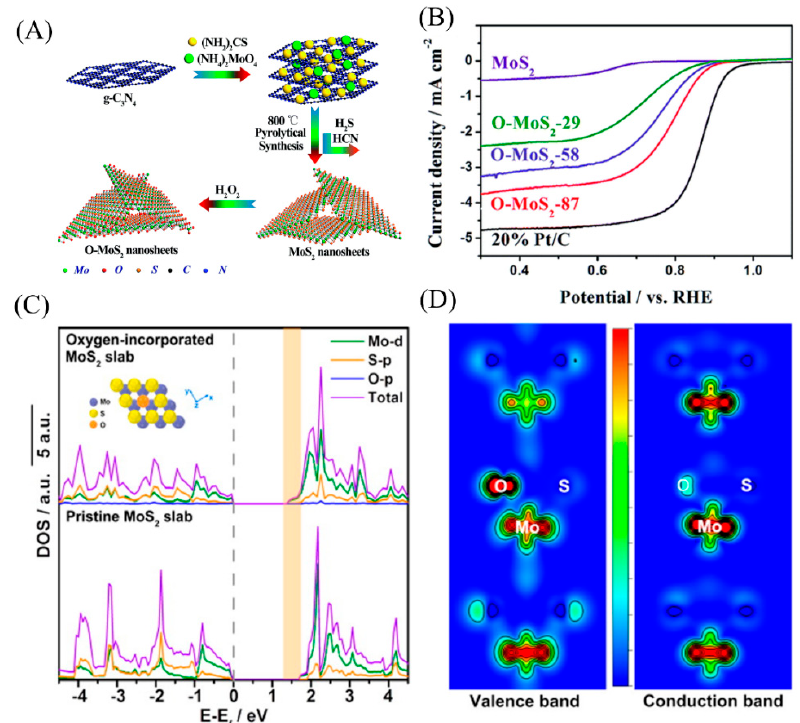
Figure 7. ( A ) Proposed synthetic protocol for incorporation of oxygen into ultrathin MoS 2 nanosheets. ( B ) ORR performance test for O-MoS 2 and pristine MoS 2 nanosheets as well as 20% Pt/C in oxygen-saturated 0.1 M KOH. Reproduced with permission from [51] Copyright © 2021 The Royal Society of Chemistry. ( C ) Calculated density of states (DOS) of the oxygen-incorporated MoS 2 slab (top) and the pristine 2H-MoS 2 slab (bottom). The orange shading clearly indicates the decrease in bandgap after oxygen incorporation. ( D ) The charge density distributions of the valence band (left) and conduction band (right) near the oxygen atom in oxygen-incorporated MoS 2 ultrathin nanosheets. Reproduced with permission from [85] Copyright © 2021 The American Chemical Society.